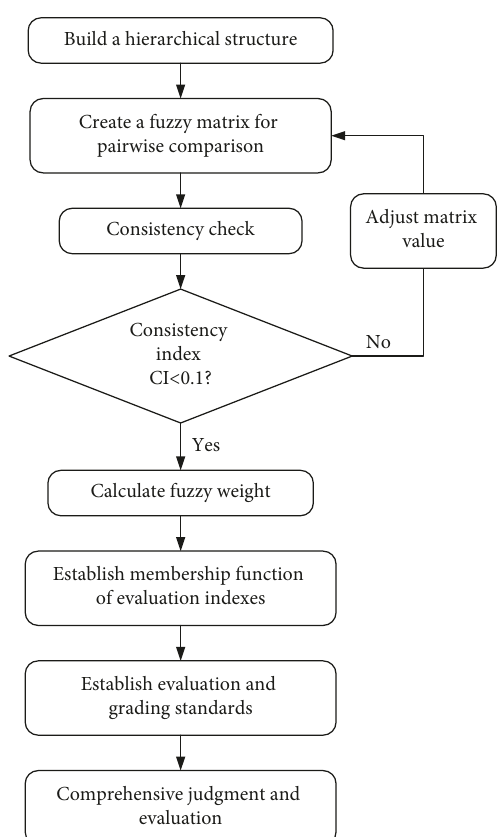
Figure 4: Analytical process of